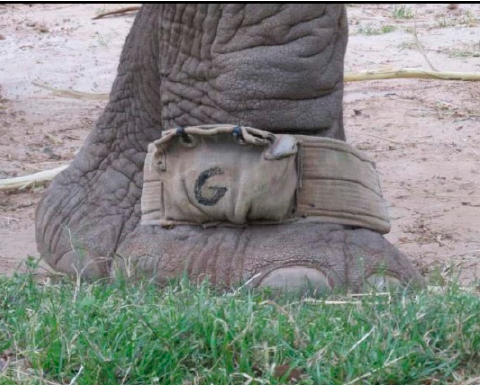
Figure 8. RFID tracking anklet developed by Dallas Zoo (Photo: Dallas Zoo Management Inc.).